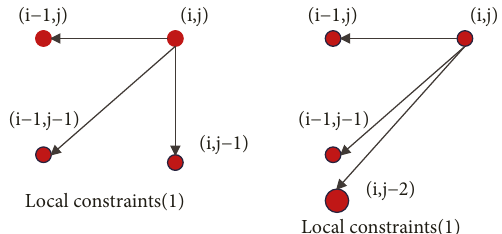
Figure 2: Schematic diagram of local constraints.